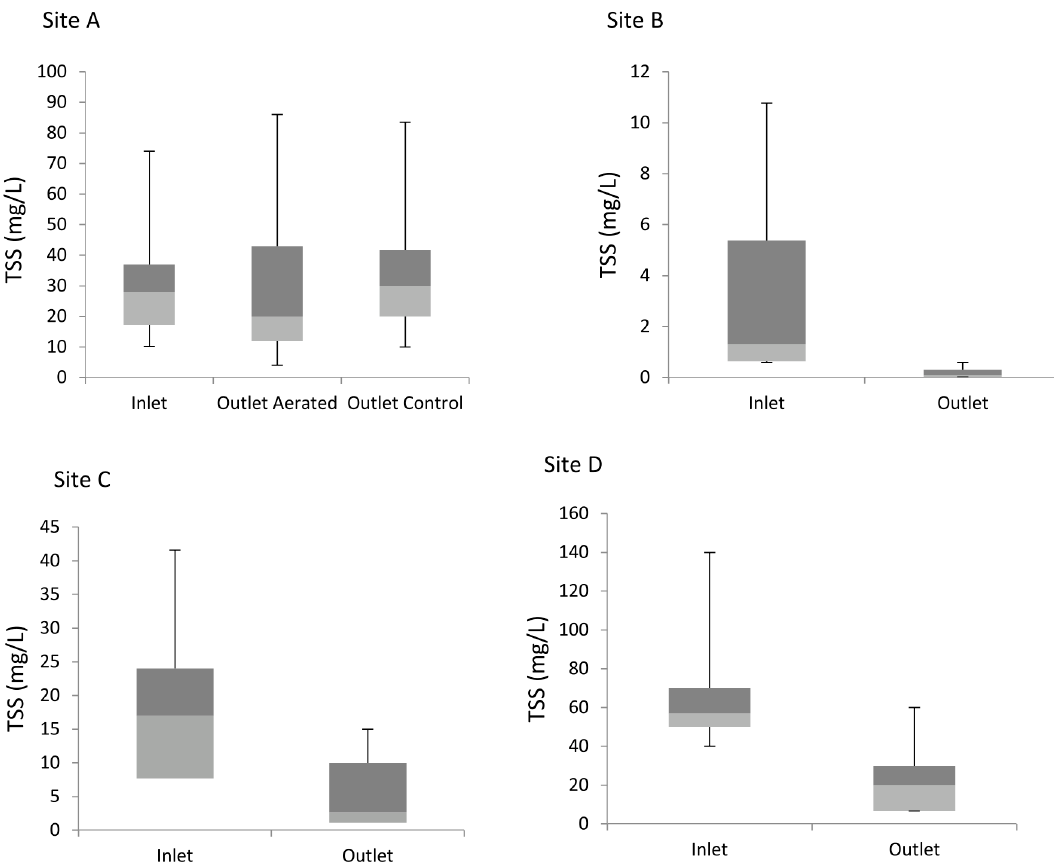
Figure 8. Box and whisker plot of TSS, concentrations at the inlet and the outlet of the control and aerated beds. The box represents the interquartile range; the line indicates the mean and the whiskers the 25th and 75th percentiles.